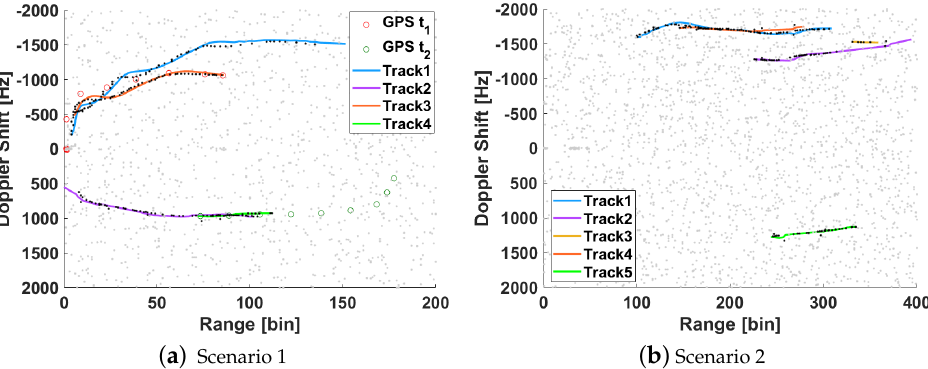
Figure 18. Maps of cumulative detections at the output of CA-CFAR, tracker tracks with their associated detections and GPS ground truth (only for scenario